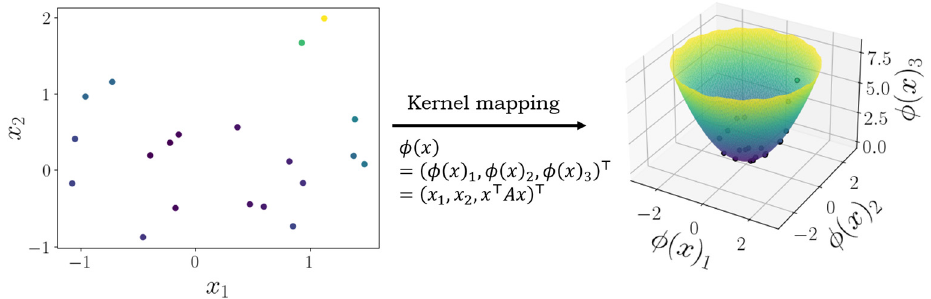
Figure 1. ( Left ) Original data X ∈ R 20×2 does not exhibit obvious structure with respect to labels (in- dicated by color). ( Right ) After mapping to ϕ ( X ) ∈ R 20×3 given some matrix A , the data is observed to lie on the surface of a quadratic. Kernel methods make use of a mapping ϕ ( X ) by operating on the kernel matrix ϕ ( X ) ϕ ( X T ) ∈ R N×N without defining ϕ explicitly but instead in terms of the kernel matrix ϕ ( X ) ϕ ( X T ).